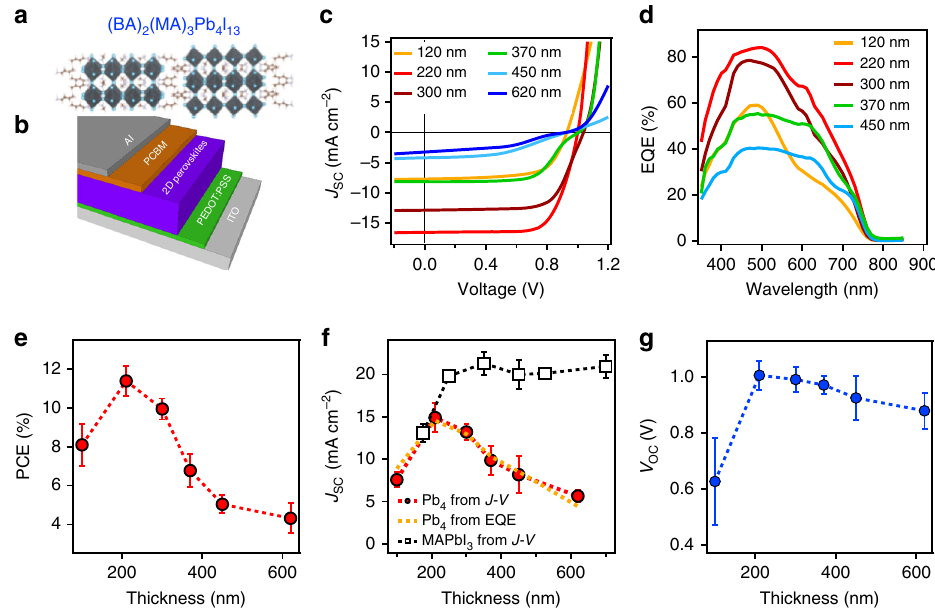
Fig. 1 Photovoltaics with various absorber thickness evaluated by J – V characteristics. a Molecular structure of BA 2 MA 3 Pb 4 I 13 (Pb 4 ) and b planar solar cell device structure used in this study. c J – V curve under AM 1.5 G solar-simulated light with 1-Sun equivalent power and d EQE spectrum collected under short-circuit condition with monochromatic light for planar device with various Pb 4 fi lm thicknesses. e – g Extracted average PCE, J SC and V OC as a function of fi lm thickness. The J SC for a device with methyl ammonium lead triiodide (MAPbI 3 ) as an absorber in the same structure is measured as a comparison in f (black curve). Error bars in e , f were s.e.m. collected over eight devices of various absorber thickness for